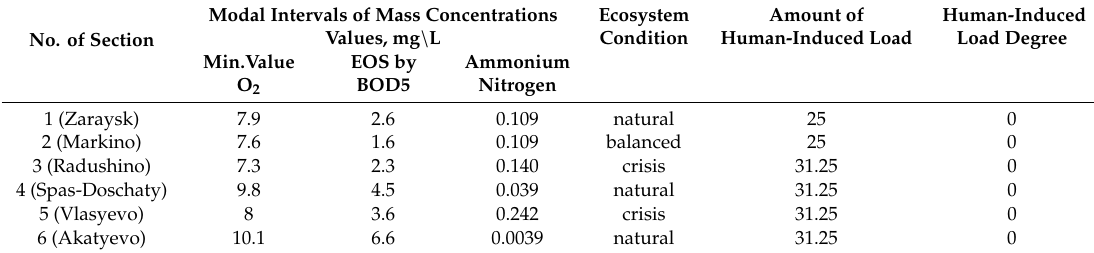
Table 2. The scale of assessing the condition of the Osetr and Oka rivers ecosystems according to the degree of the human-induced load.